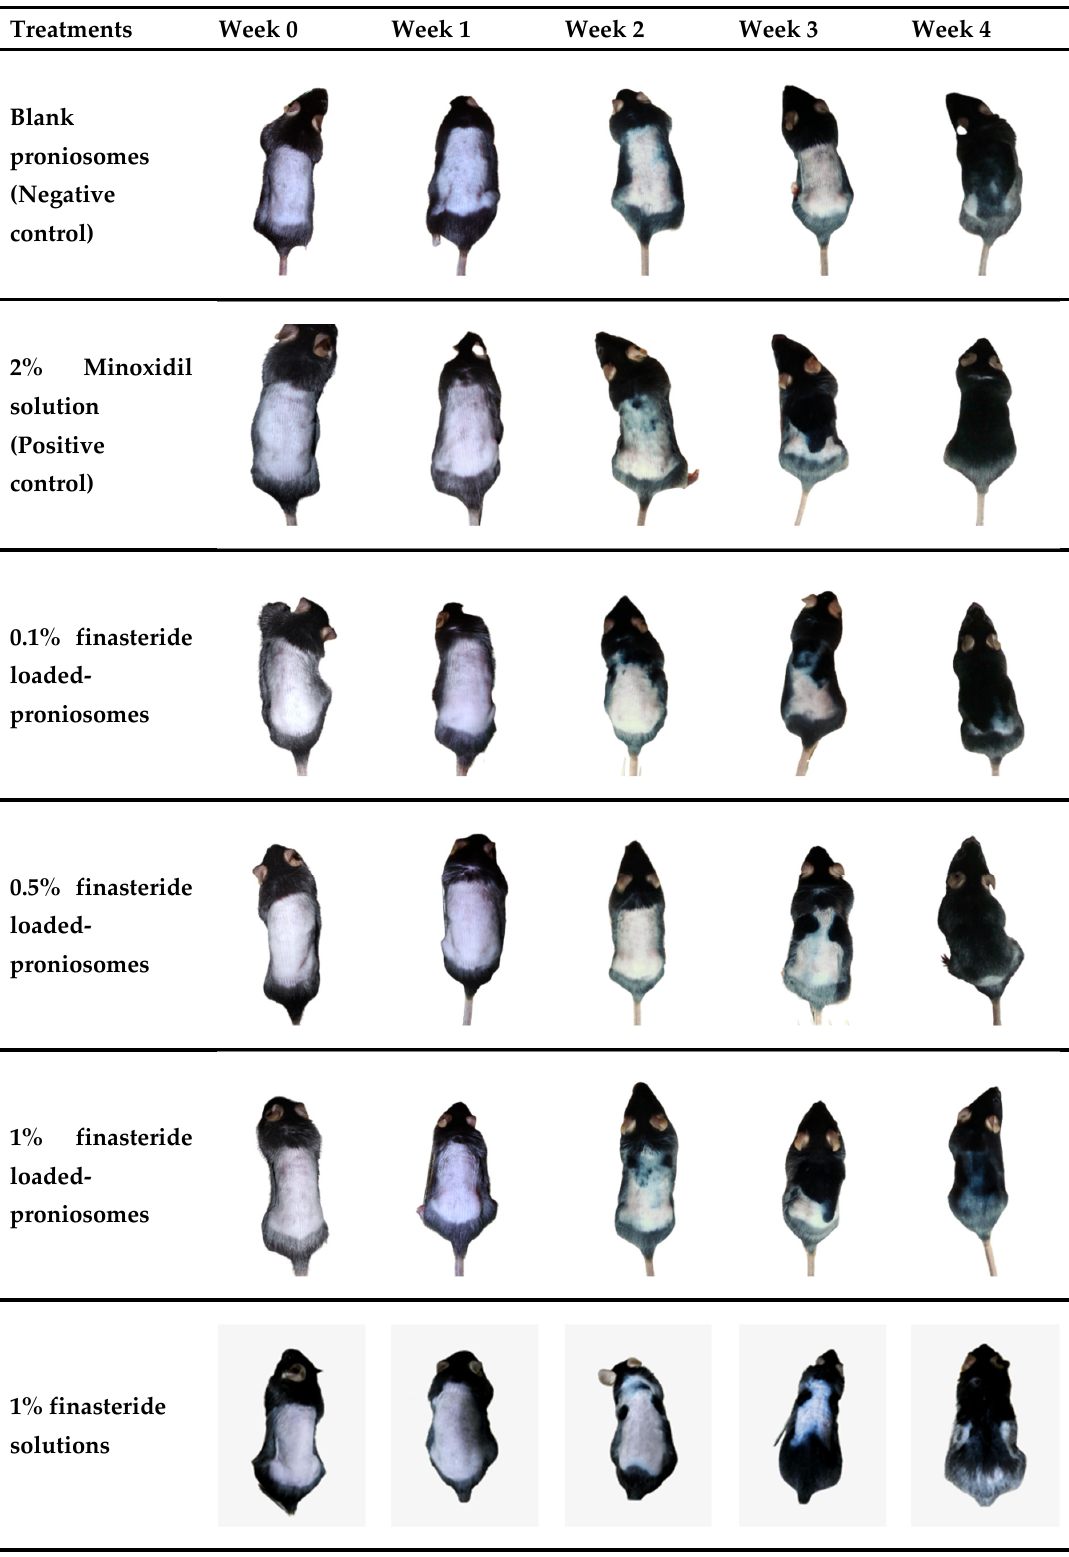
Figure 8. Photograph displaying the hair growth-promoting effects of various treatments in mice. The dorsal skins of 7-week-old C57BL/6 mice were shaved and topically applied with proniosomes (blank control), 2% minoxidil (positive control), 0.1%, 0.5% and 1% FLP and 1% FS,